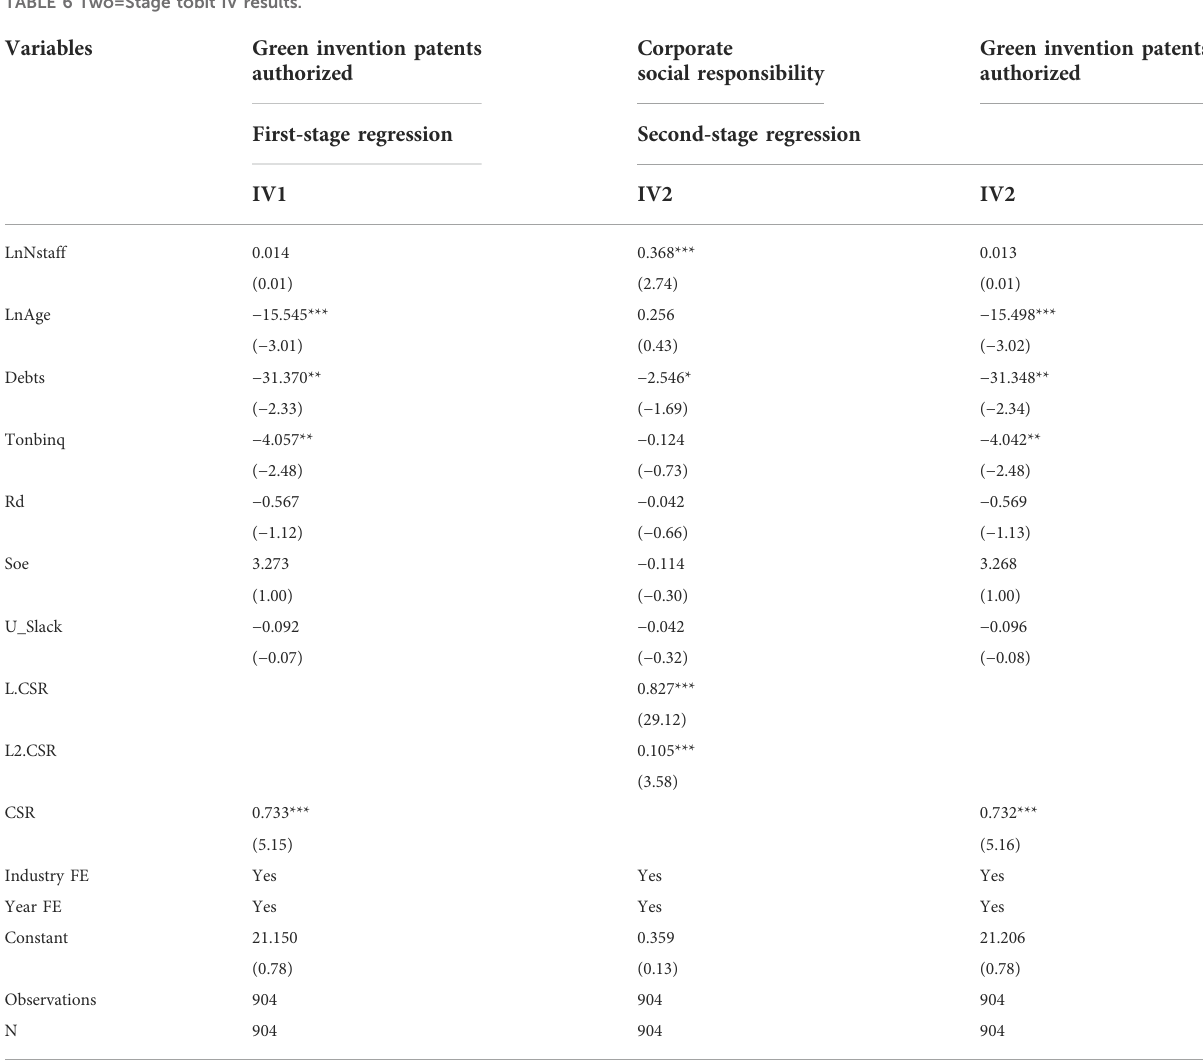
TABLE 6 Two=Stage tobit IV